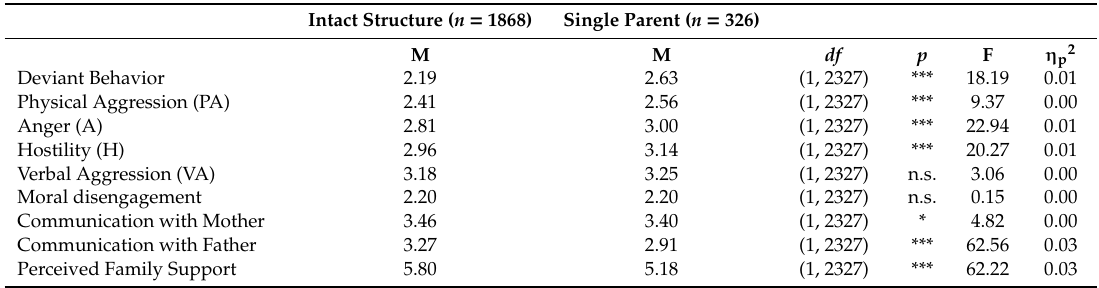
Table 3. ANOVAS on all the variables examined with family structure as between-subject